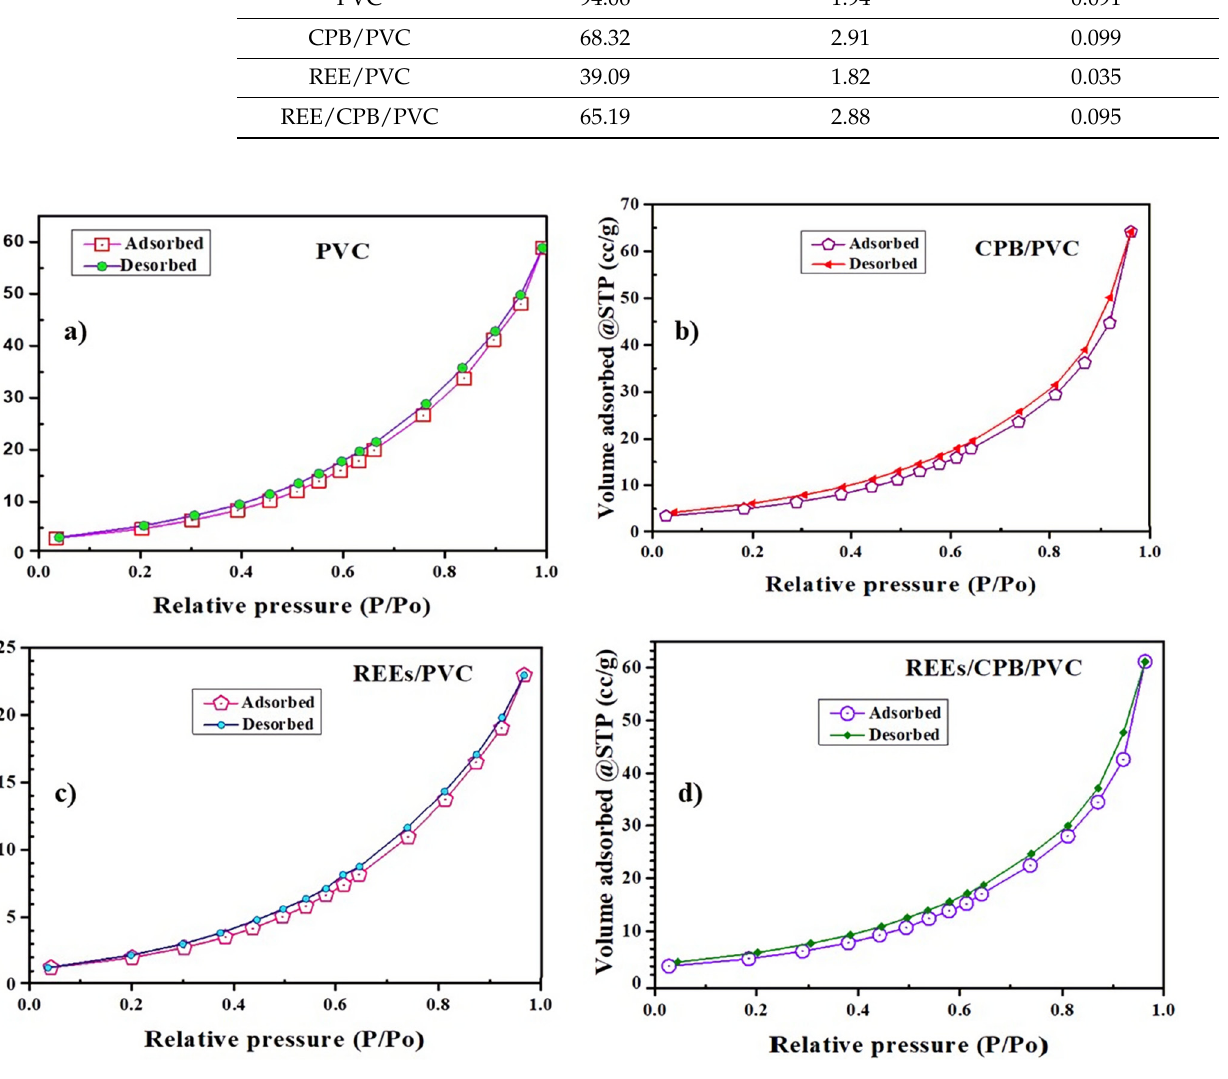
Figure 3. N 2 sorption/desorption isotherm of ( a ) PVC, ( b ) CPB/PVC, ( c ) REE/PVC, and ( d ) REE/CPB/PVC.